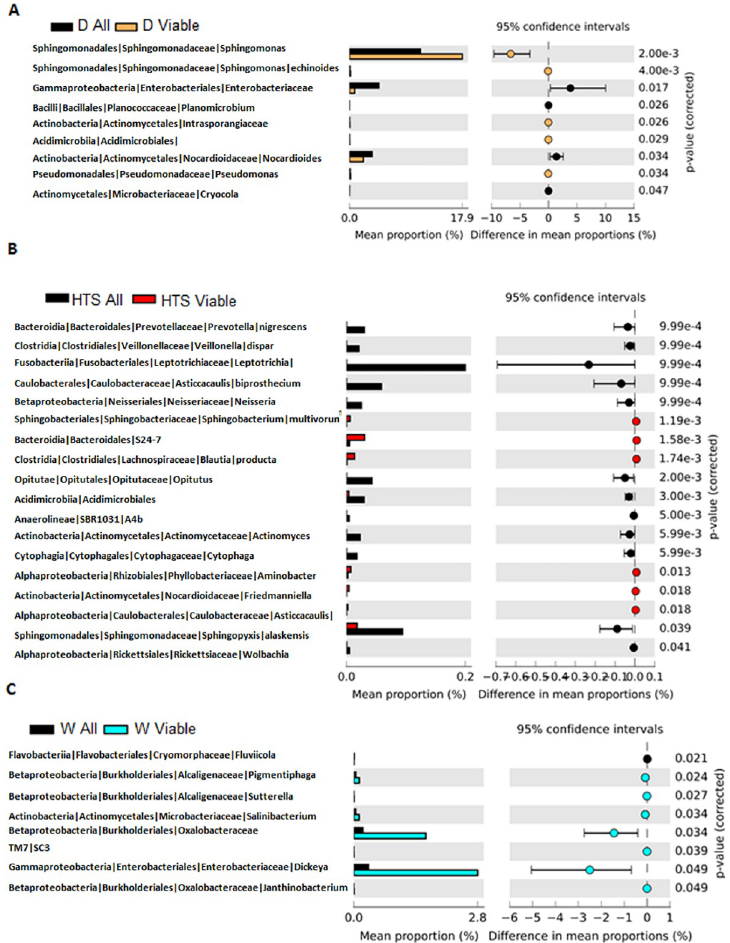
Fig 3. OTU viability following regimens OTUs from dry (total n = 13, viable n = 11) (A), HTS (total n = 7, viable n = 6) (B) and soaked (total n = 7, viable n = 11) (C) hay samples, all represents total bacteria and viable represents viable bacteria after PMA